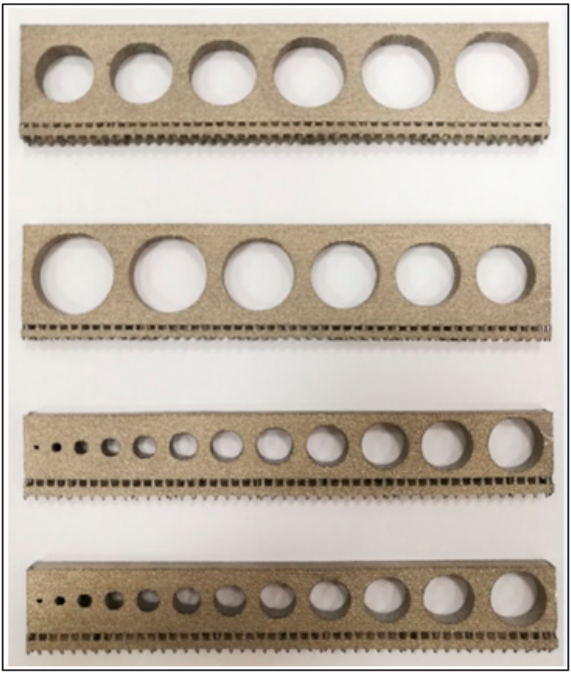
Figure 12. Fabricated holes without support structures.